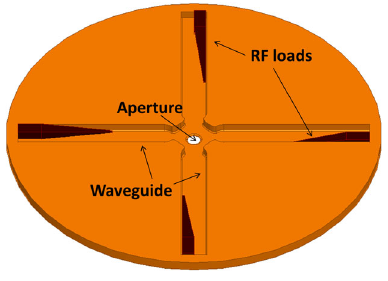
FIG. 1. Geometry of single CLIC-G